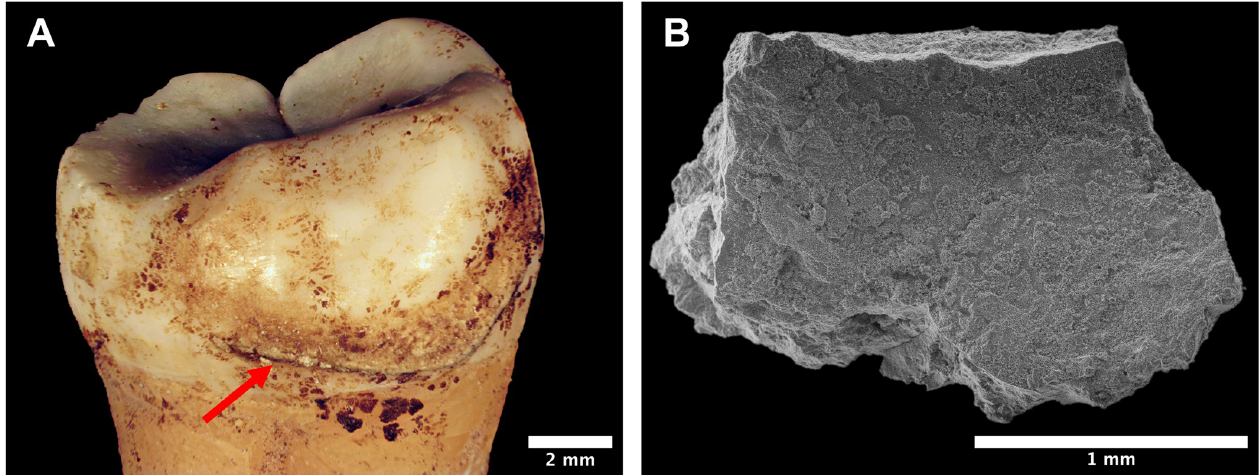
Fig 2. Example of in situ calculus deposit selected for analysis. (A) Supragingival calculus deposit (indicated by red arrow) on buccal surface of right M 3 , individual SK 63, KDK1; (B) Proximal surface (surface previously adhering to tooth) of sampled calculus from same individual under SEM.